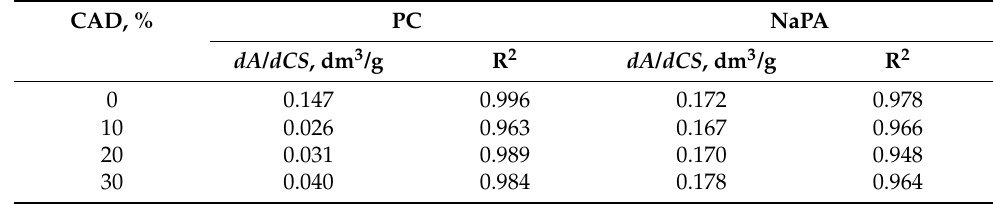
Table 4. Indicators of surface activity of PC and NaPA at the interface with titanium dioxide.